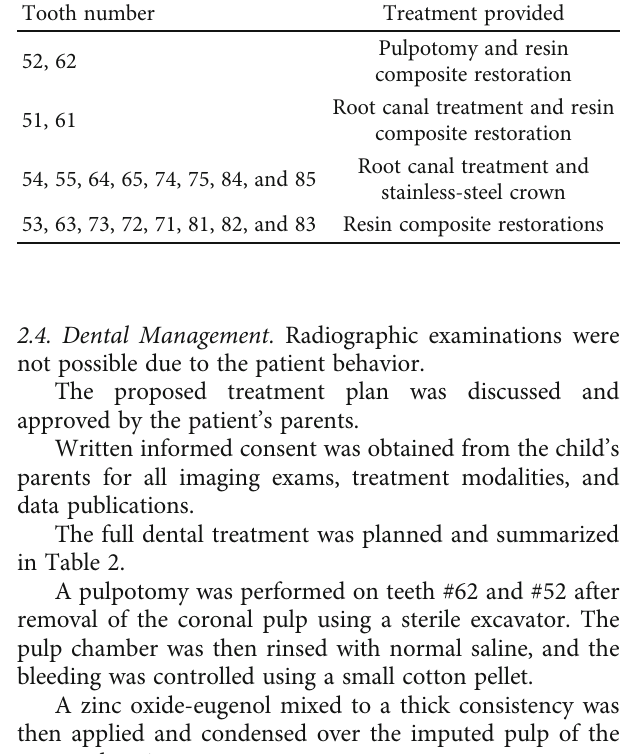
Table 2: Summary of the provided treatments. Tooth